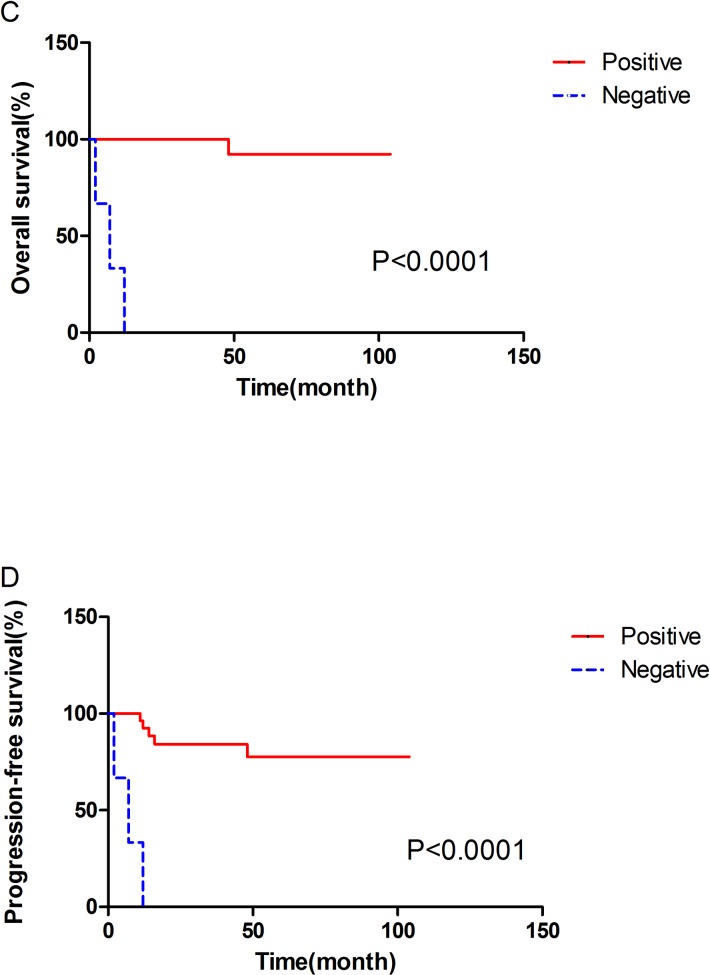
Survival curves of overall survival (C) and progression-free survival (D) between inferior vena cava tumor thrombosis-positive and -negative patients. The overall survival and progression-free survival between inferior vena cava tumor thrombosis-positive and -negative patients were statistically significant.